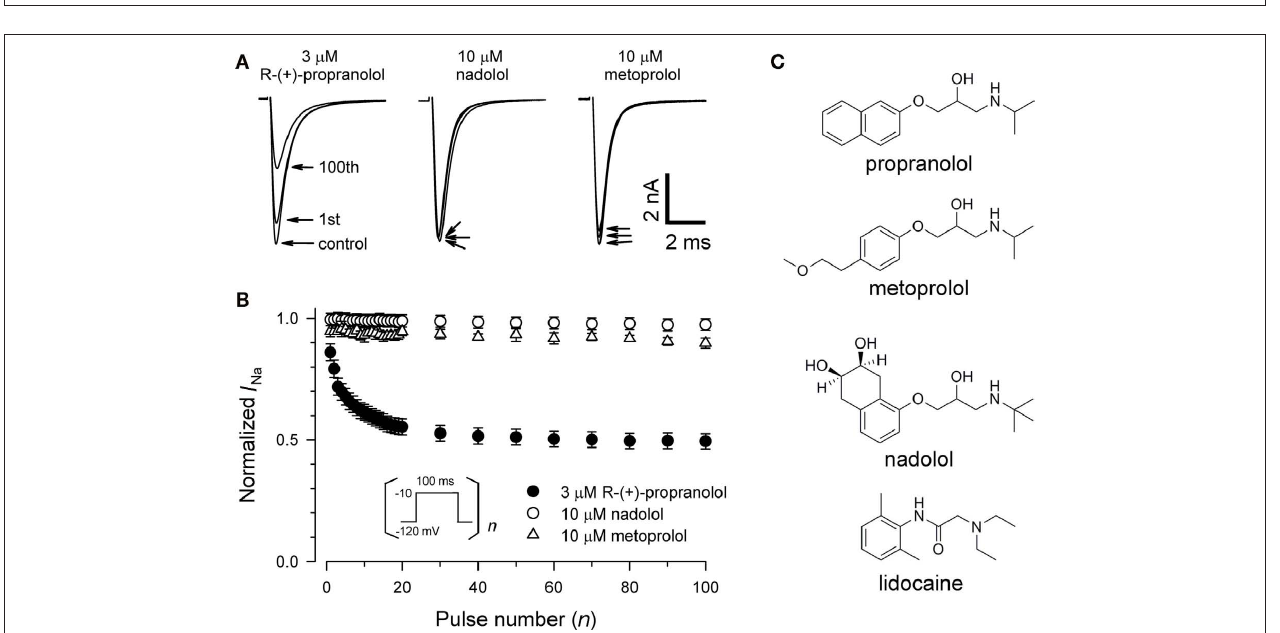
were applied to the bath solution. (B) Comparison of use-dependent inhibition of 1.5 sodium V Na 1.5 V the peak of the first current trace, and plotted as a function of pulse number ( n = 7–12). For clarity, not all data points are plotted. There was no use- dependent reduction of peak sodium current at 1 Hz in the control condition. (C) Chemical structures of propranolol, metoprolol, nadolol, and lidocaine.